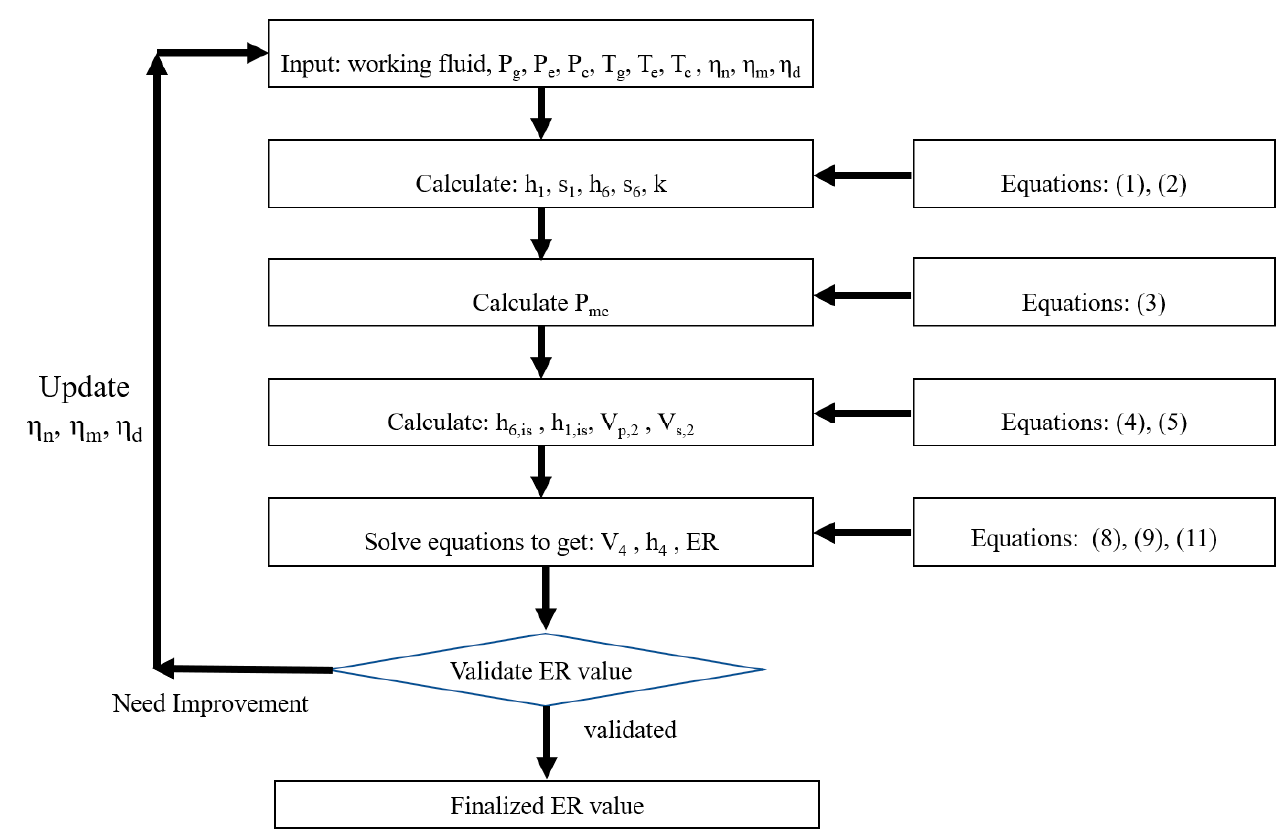
Figure 4. Procedure of computation used in the model .